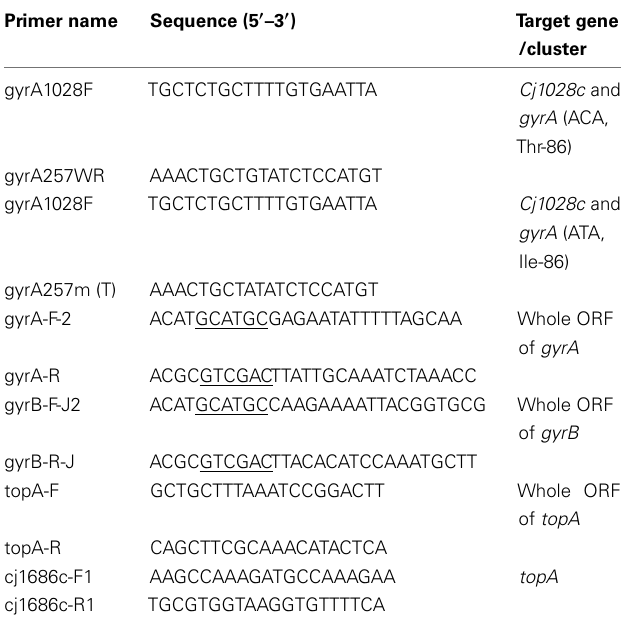
Table 2 | Key PCR primers used in this